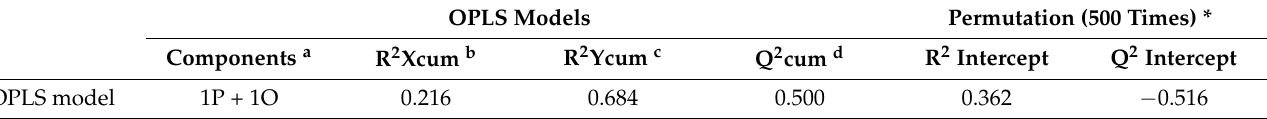
Table 3. Parameters OPLS